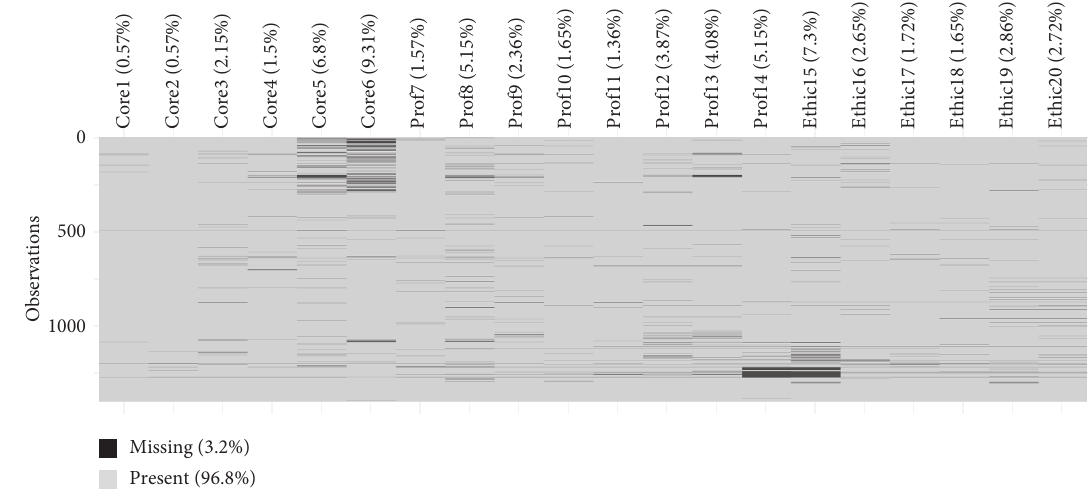
Figure 1: Heatmap visualization of missing data for the SETE Table 1: Student evaluations of teacher’s effectiveness scale.